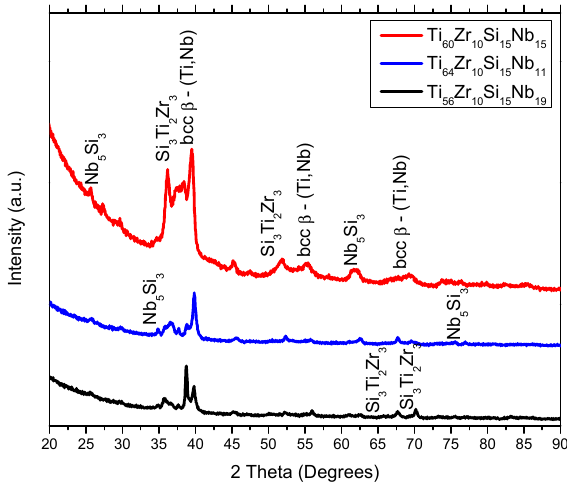
Figure 4. X-ray diffraction patterns of Ti–Zr–Si–Nb alloys obtained with 36 m/s peripheral speed— MS2, after heat treatment.